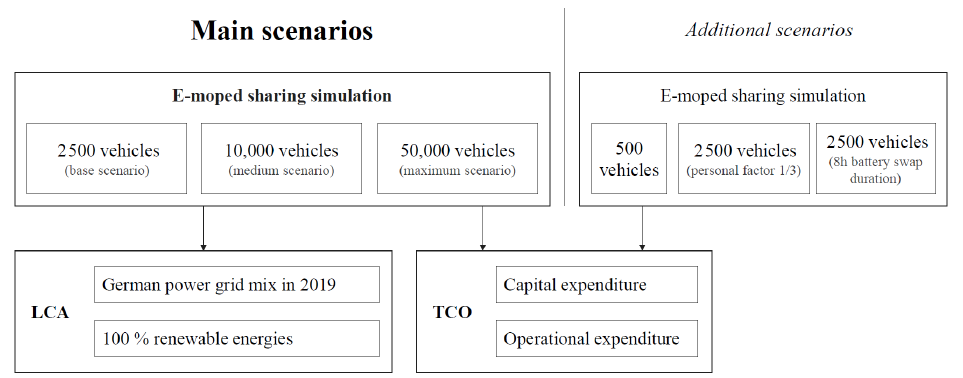
Figure 3. Schematic representation of the